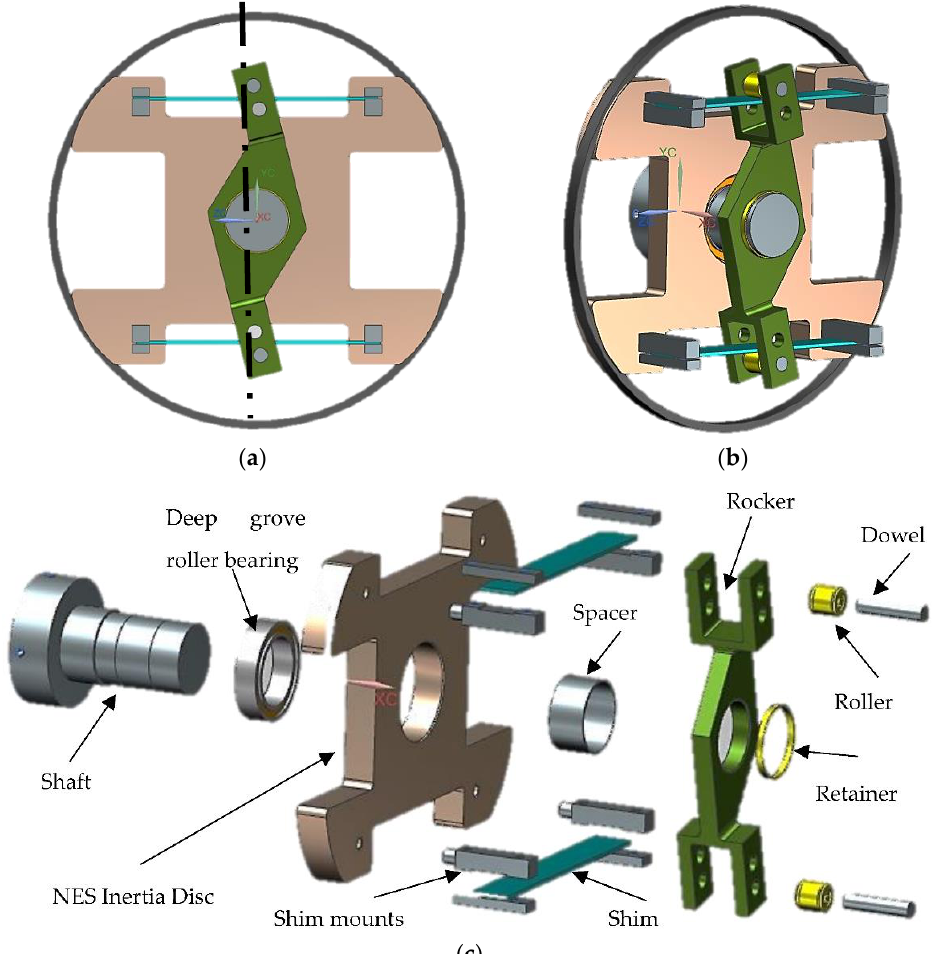
Figure 4. ( a ) Front, ( b ) inclined and ( c ) exploded CAD views of the NES